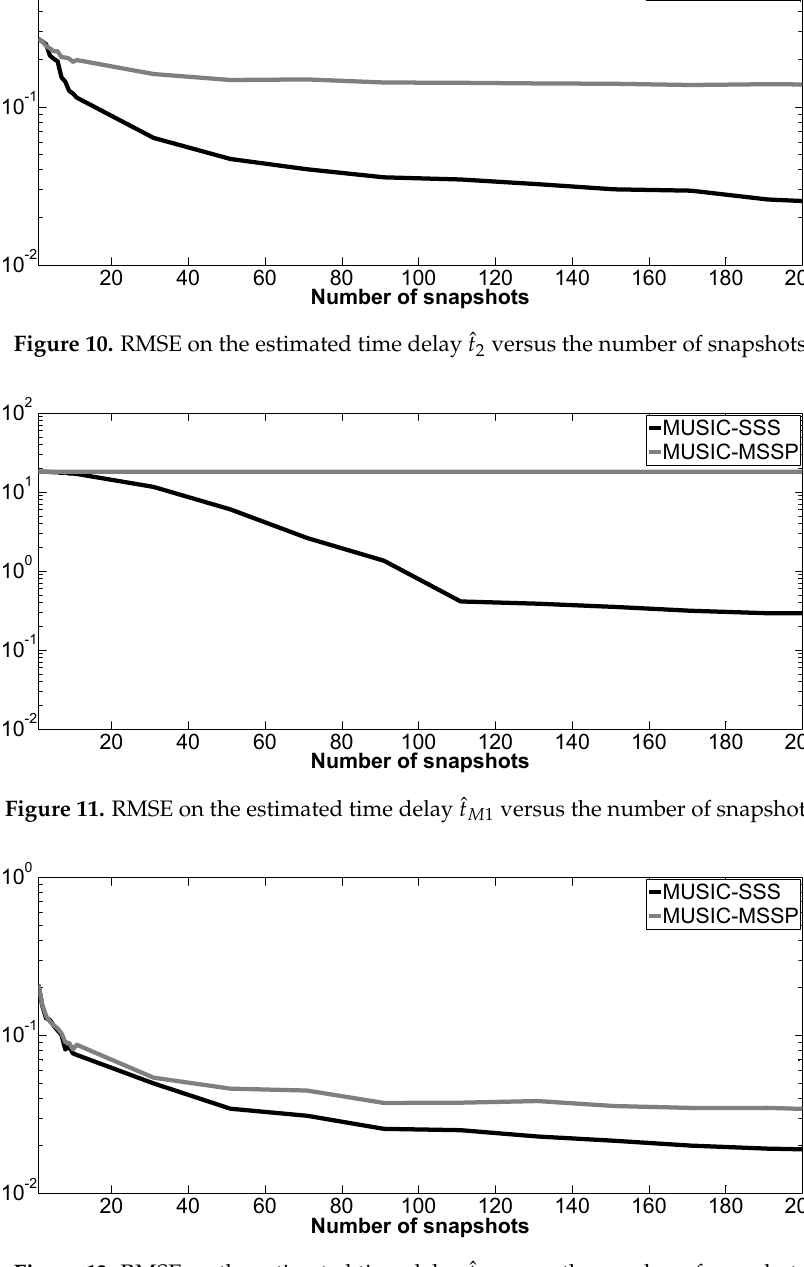
Figure 12. RMSE on the estimated time delay ˆ t 3 versus the number of